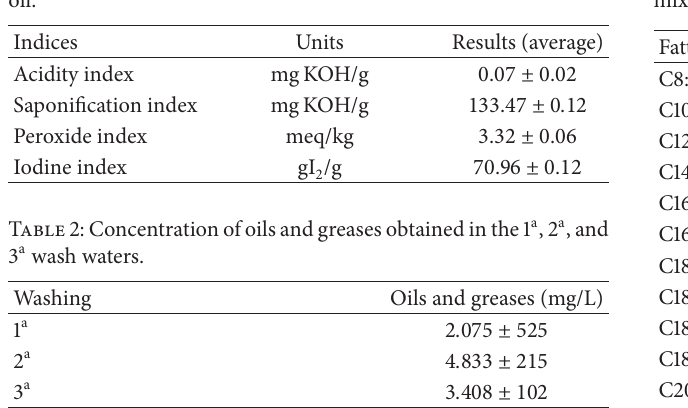
Table 1: Physicochemical characterization of the viscera of tilapia oil.